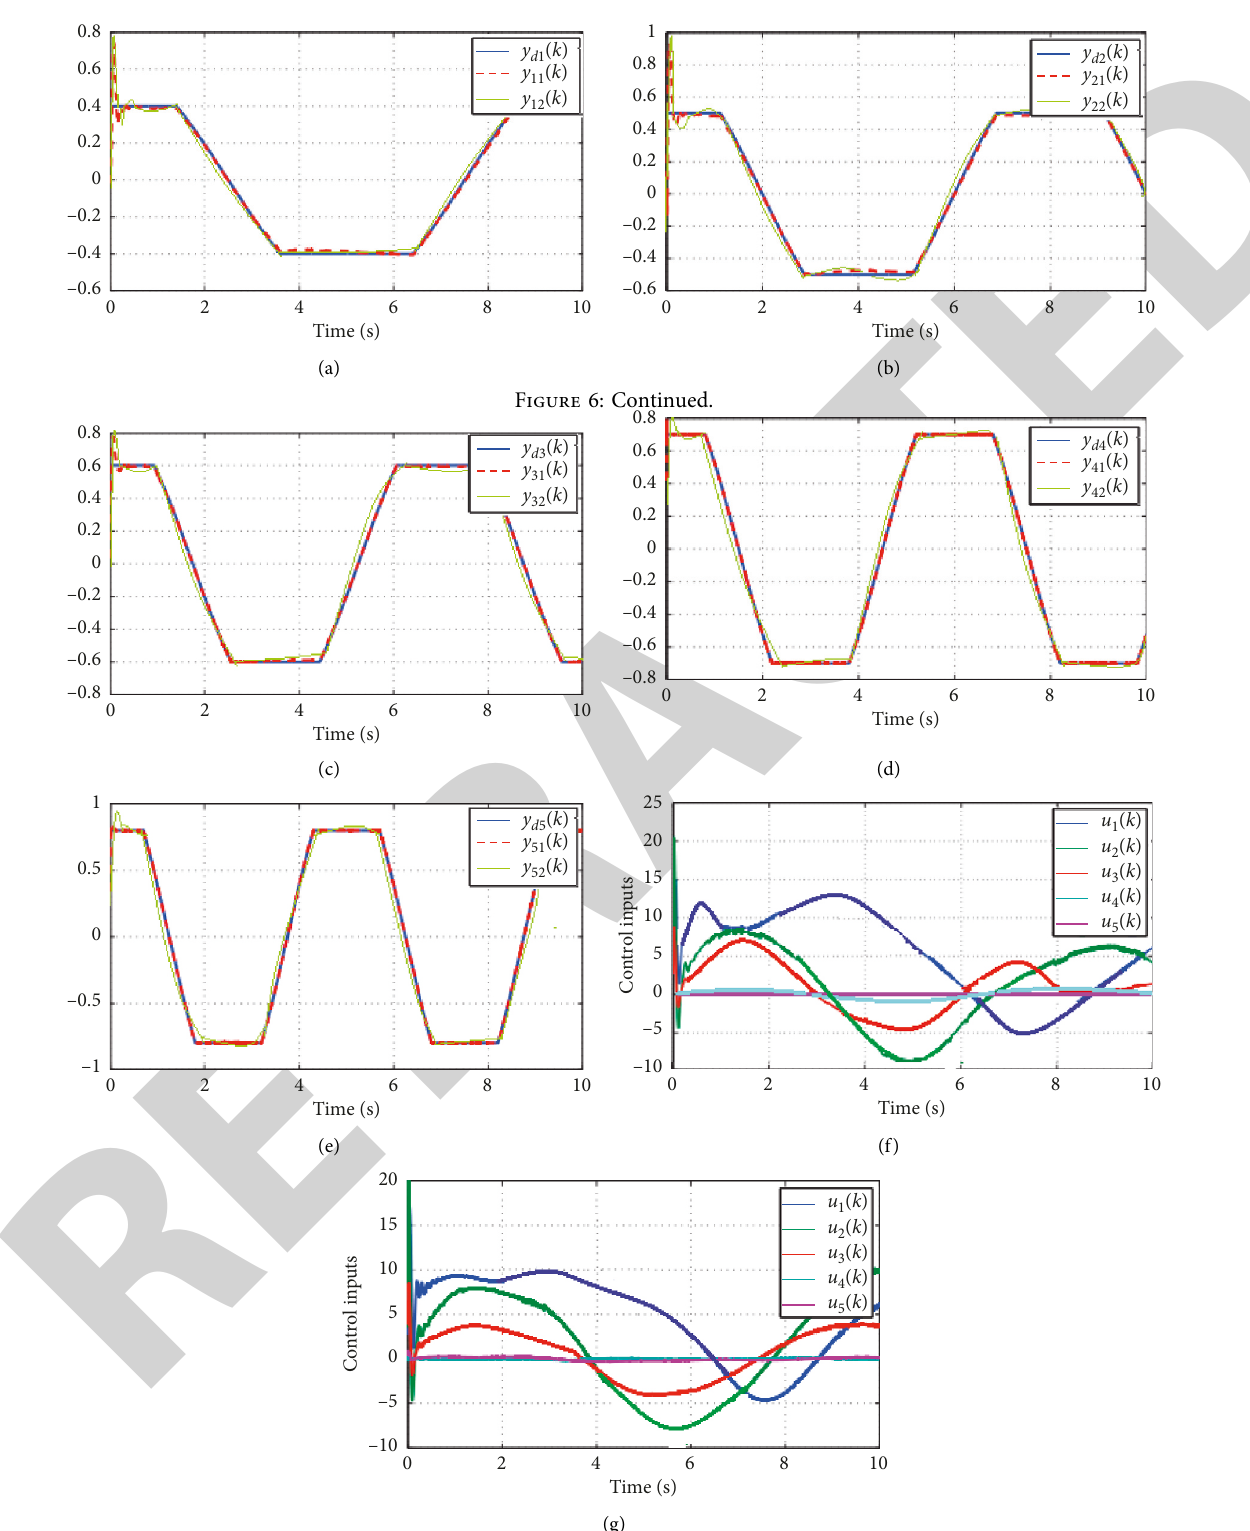
Figure 6: Comparison results with five joints under control (“11”represents MFSMC,“22” represents MFASMCNN). (a) Tracking per- formance of y 1 ( k ). (b) Tracking performance of y 2 ( k ). (c) Tracking performance of y 3 ( k ). (d) Tracking performance of y 4 ( k ). (e) Tracking performance of y 5 ( k ). (f) Control inputs of u 1 ( k ), u 2 ( k ), u 3 ( k ), u 4 ( k ) and u 5 ( k ) with MFSMC. (g) Control inputs of u 1 ( k ), u 2 ( k ), u 3 ( k ), u 4 ( k ) and u 5 ( k ) with